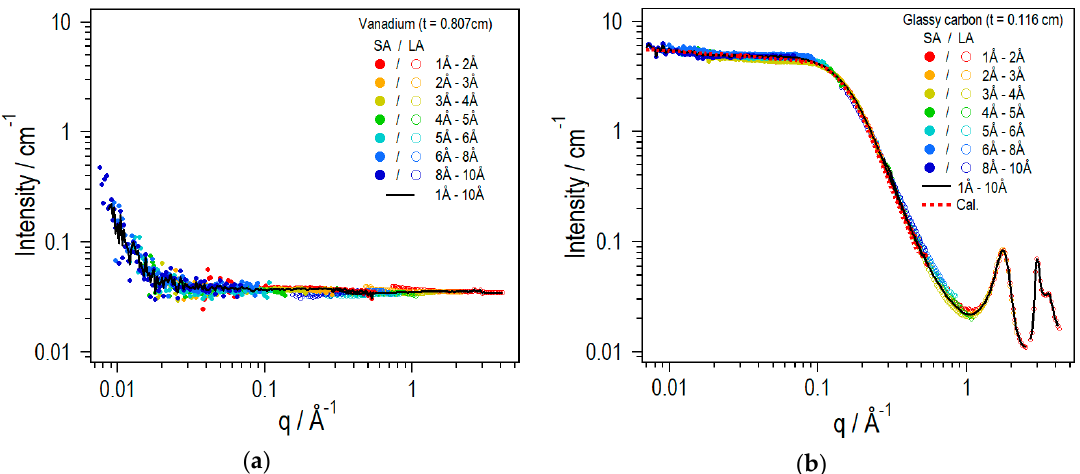
Figure 9. SANS profiles of vanadium (t = 0.807 cm) ( a ) and glassy carbon standard (t = 0.116 cm) ( b ).